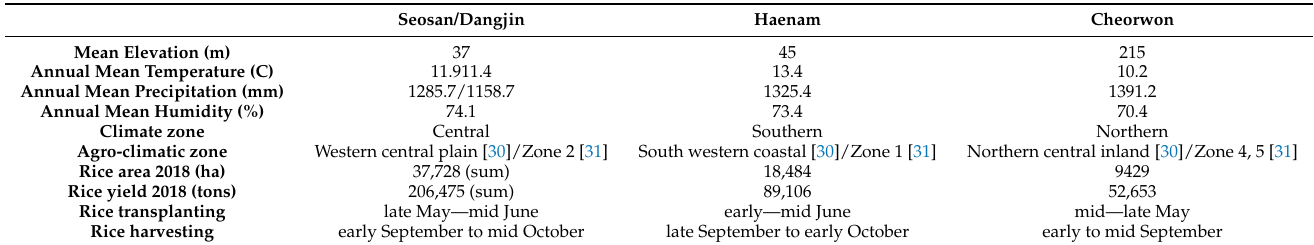
Table 1. Climatic and paddy rice cultivation characteristics for the three study sites [30,33–37].